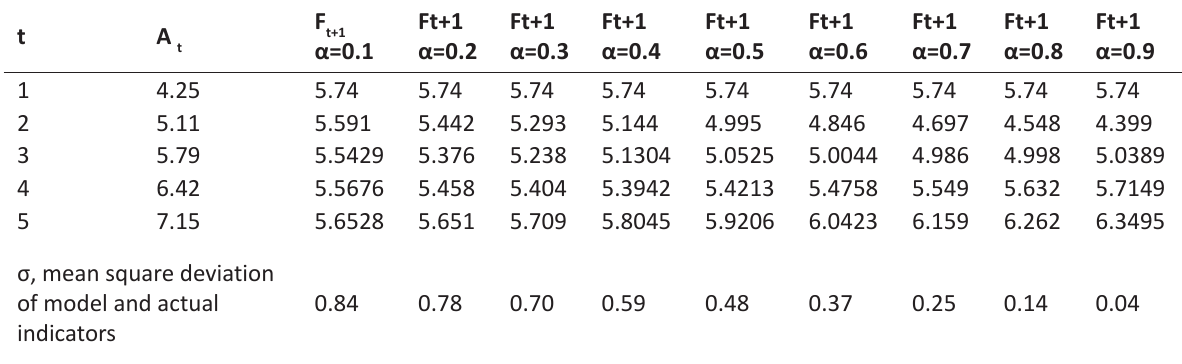
Table7. Mean square deviations of model and actual indicators in control group in October 2015 .